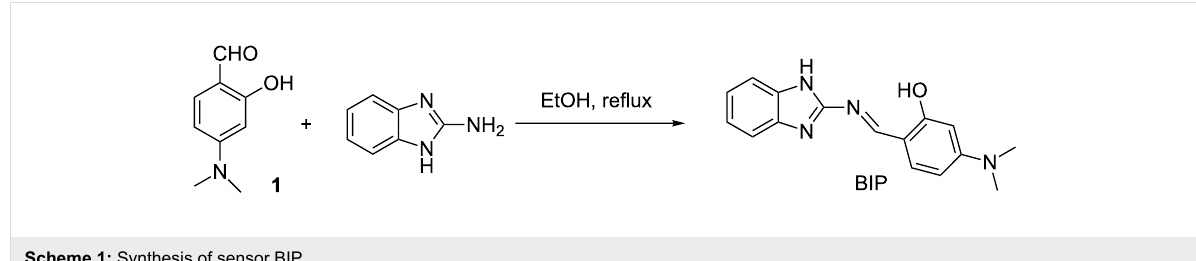
The interaction of BIP with fluoride was further investigated by UV–vis spectroscopic titration. As seen from Figure 2, the spec- tral changes with two well-defined isosbestic points (344, 270 nm) indicated the formation of a single complex between BIP and fluoride [2]. Evidence for 1:1 complex formation was also validated by non-linear least-square analysis [31] for BIP with F − . The association constant, calculated from the UV − vis plot at 410 nm as the function of anion concentration [15], was 1.25 × 10 4 ( R = 0.9926) for F − (see Figure S1 in